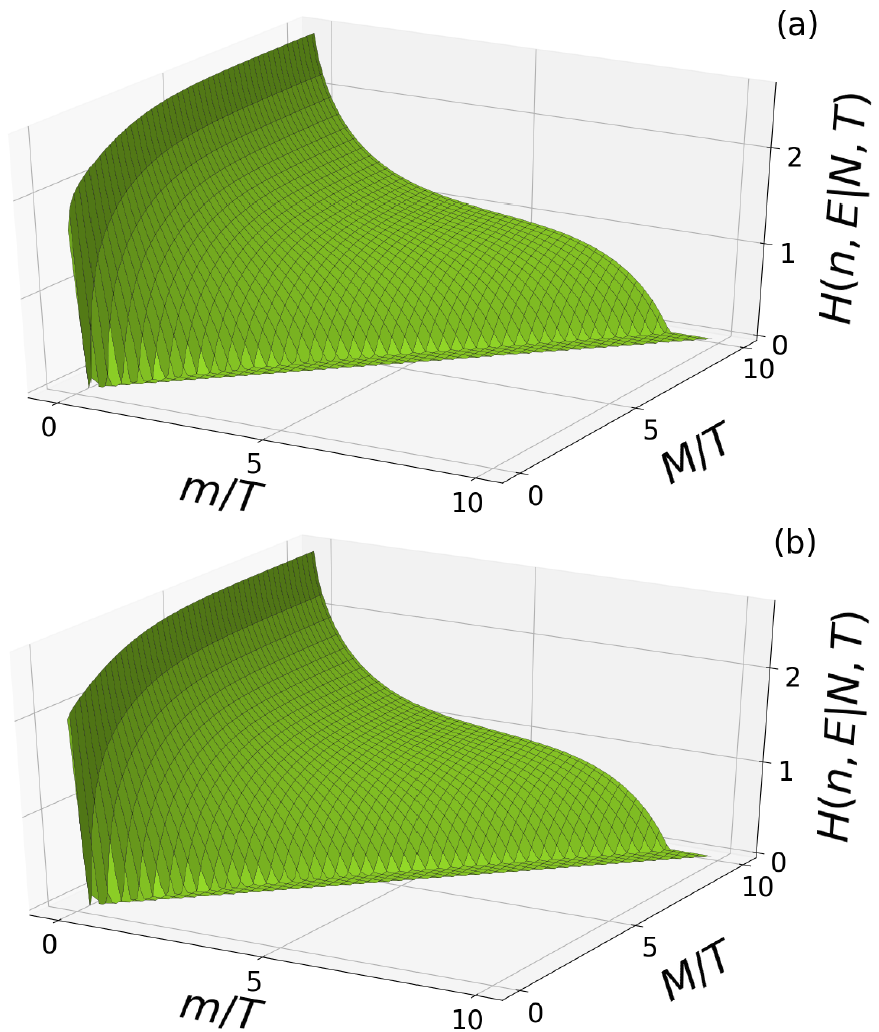
Figure 2. (Color online) The same as Figure 1 but for bosons. The spectrum of bosons contains ( a ) N = 100 and ( b ) N = 1000